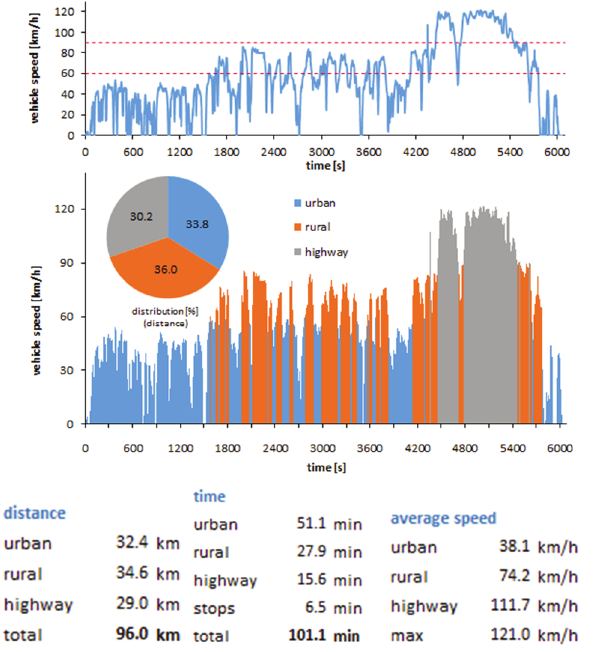
Fig. 2. AFHB, road trip for RDE